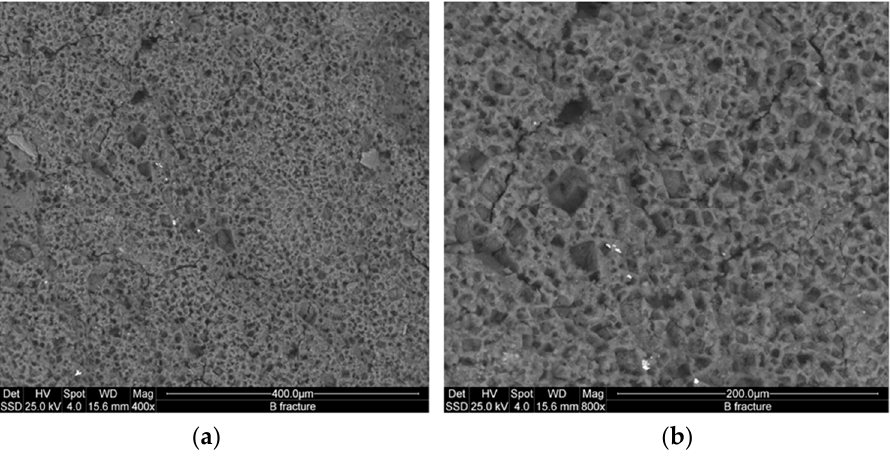
Figure 12. ESEM microstructure of fracture surface showing the homogeneous distribution of the pores with size between 0.1 and 10 µm forming from the corrosion of the iron metal during the process of black ABS mortars: ( a ) 400×; ( b ) 800× SS-IPC.